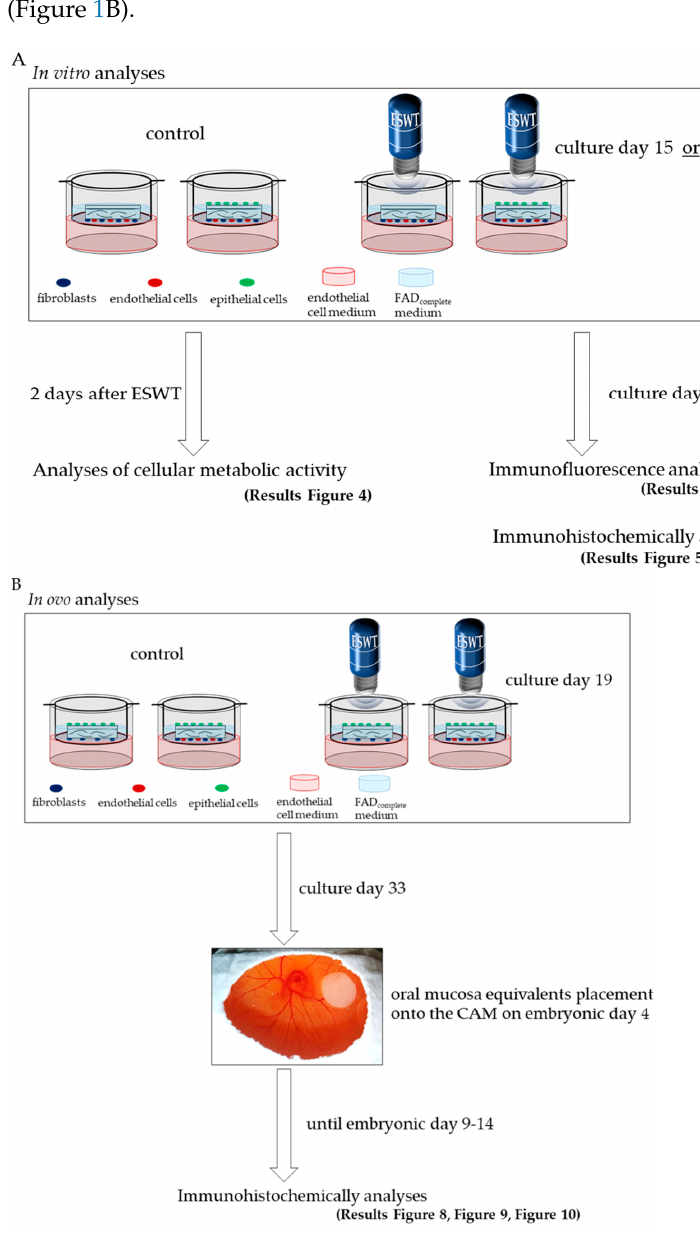
Figure 1. Schematic illustration of the experimental design. ( A ) In vitro analyses were performed to investigate the influence of ESWT during the manufacturing process of the oral mucosa equivalent. ( B ) In ovo analyses were performed to investigate the impact of ESWT on oral mucosa equivalents for in vivo applications.